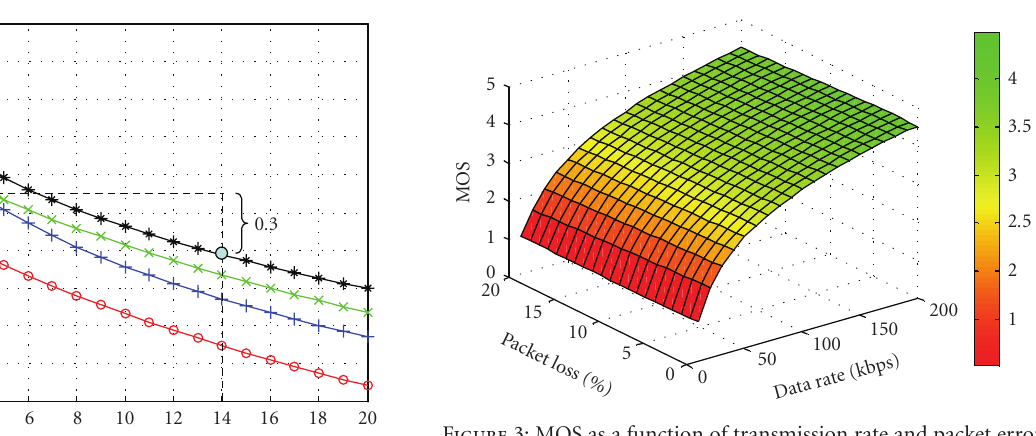
Figure 3: MOS as a function of transmission rate and packet error probability for file download